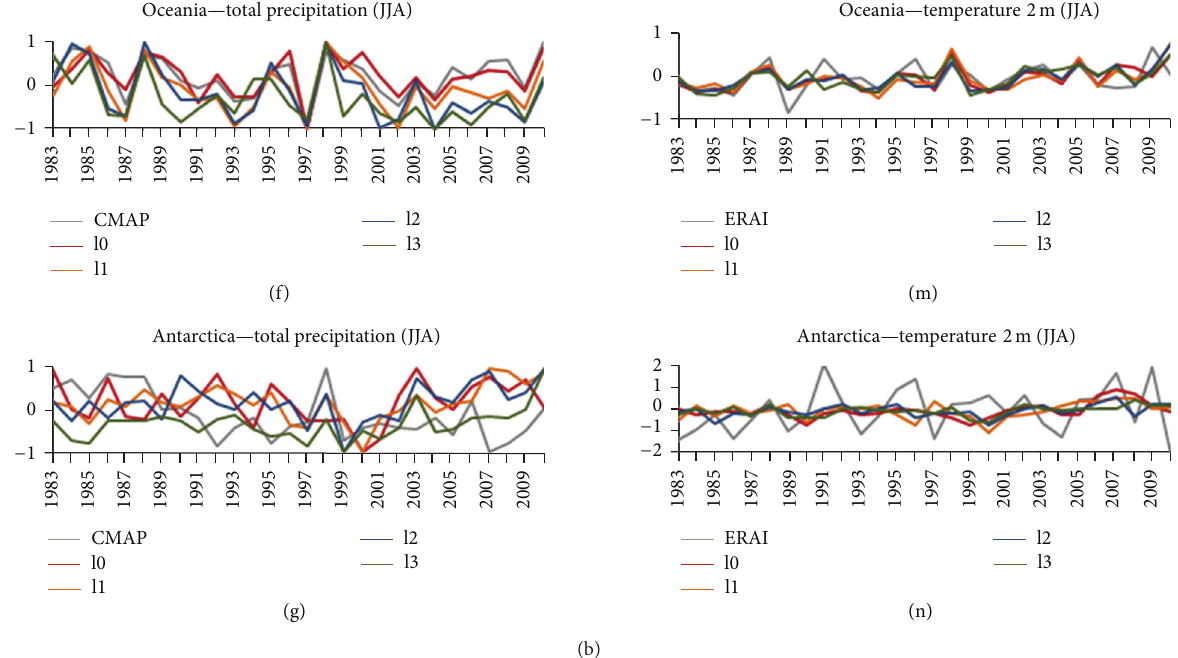
Figure 2: As in Figure 1 but for JJA